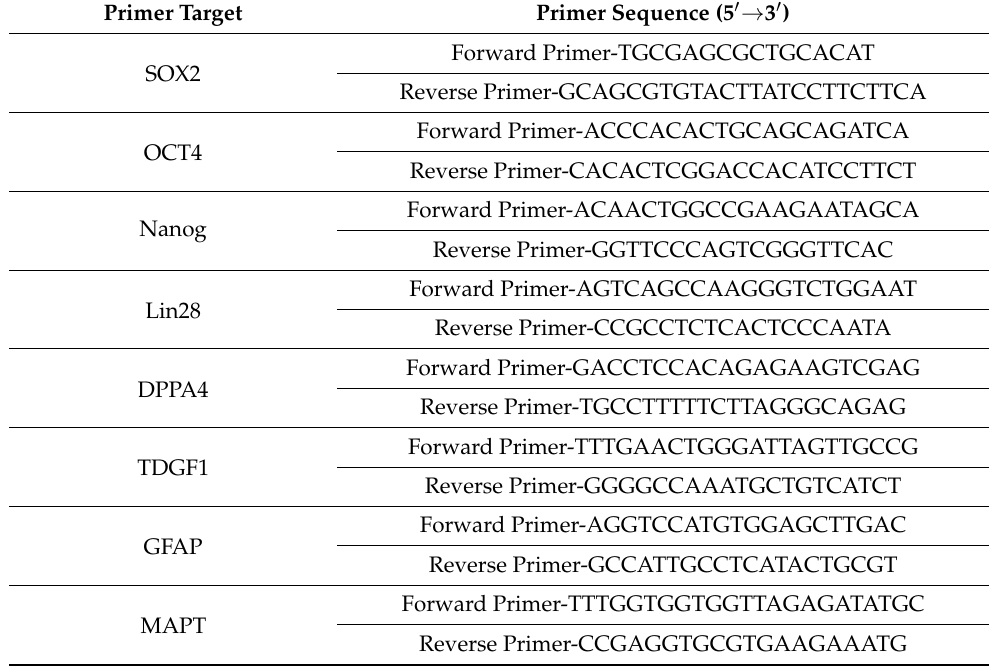
Table 2. The primer sequences for